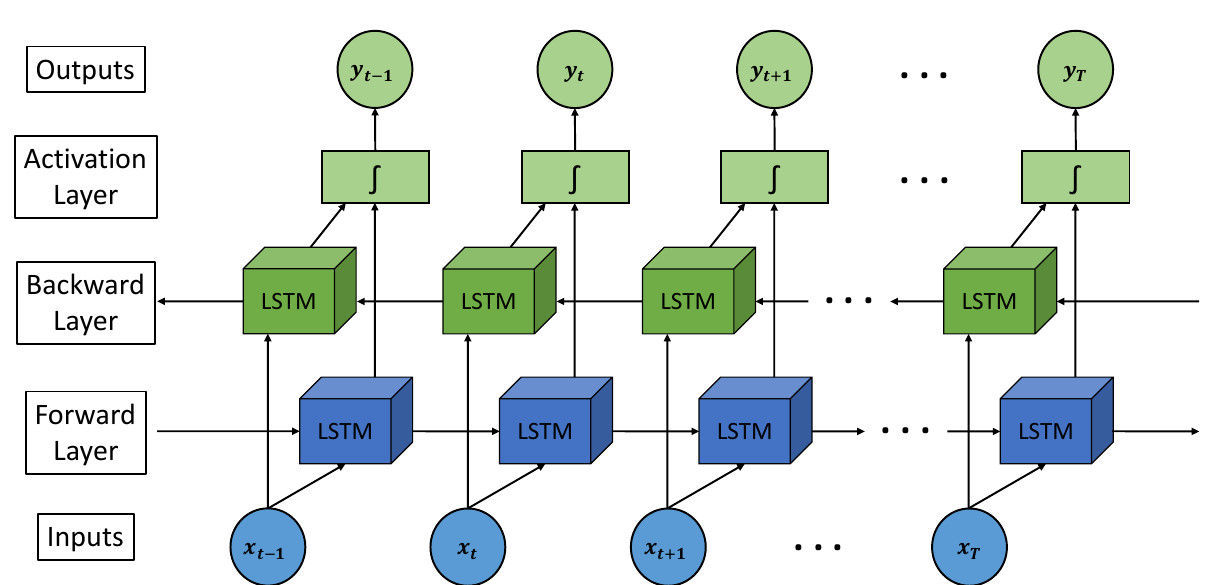
Figure 2. Architecture of a bidirectional LSTM